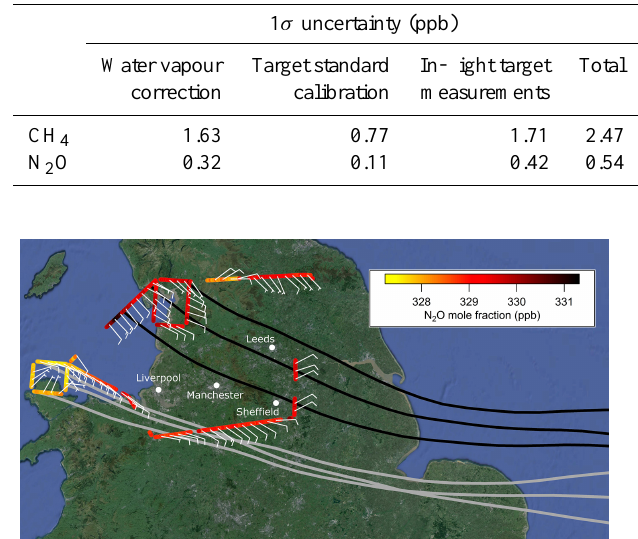
Figure 10. Aircraft flight track for flight B868, coloured by N 2 O mole fraction. Average wind speeds and directions taken over 60s are shown as a wind barbs (using the convention where each full barb represents a wind speed of 10 knots). Selected HYSPLIT back trajectories are shown for a region of enhanced N 2 O (black) and a contrasting region of lower N 2 O (grey). Map data: Google, SIO, NOAA, US Navy, NGA, GEBCO,